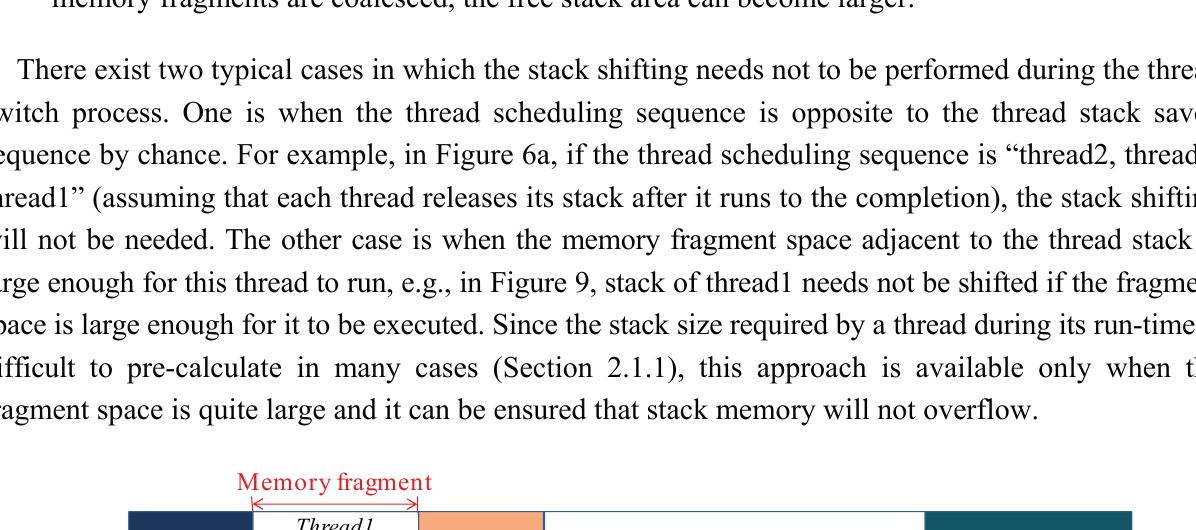
Figure 8. Memory defragmentation in the dynamic-stack allocation area. After the memory fragments are coalesced, the free stack area can become